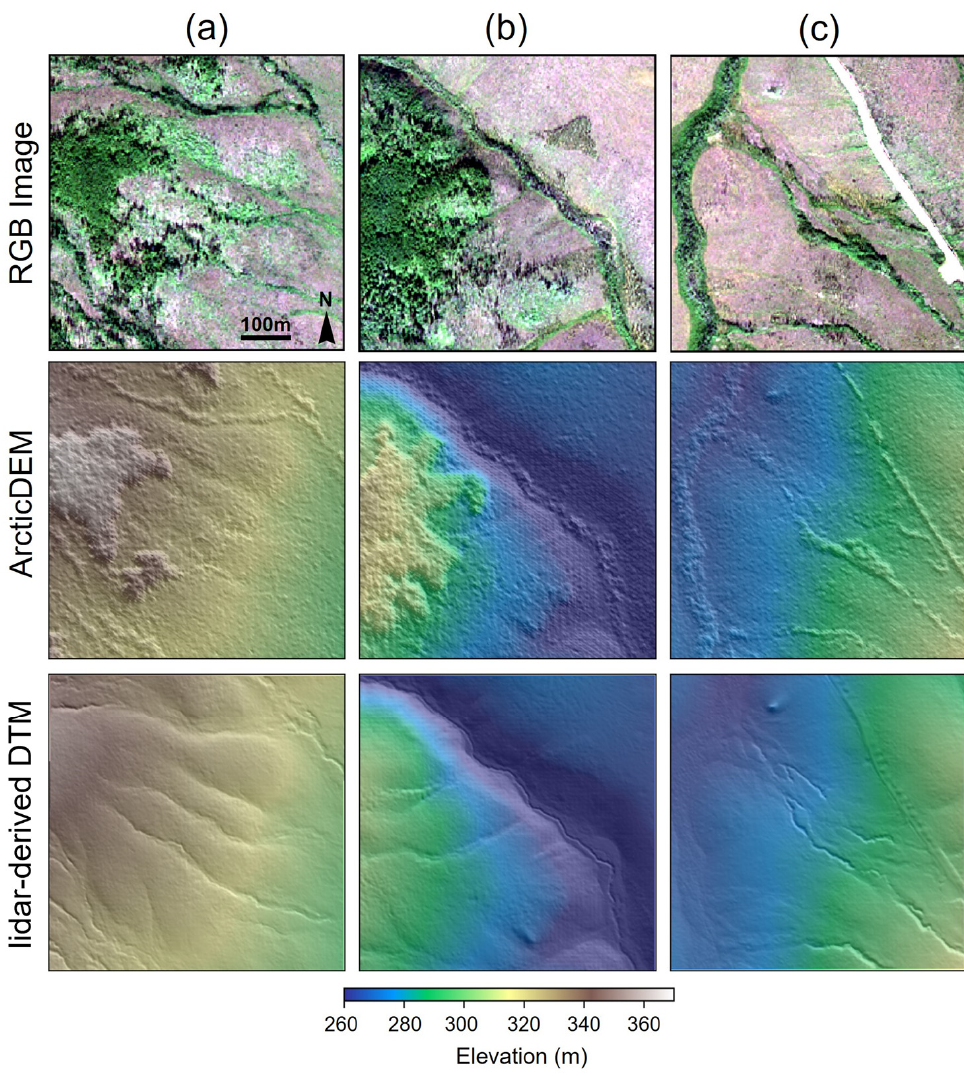
Figure 2. Vegetation and topography characteristics of three study sites, ( a – c ) correspond to Site-1, Site-2, and Site-3, respectively. The RGB image was composited from the WV-2 imagery, and the white surface at Site-3 is the concrete road.